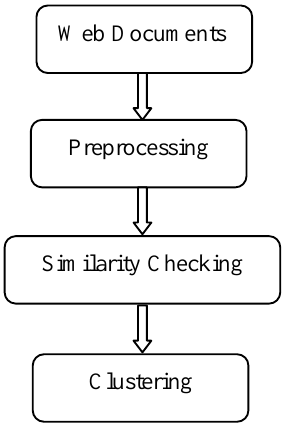
Fig. 2: Flow Diagram of Semantic-Based Model for Document